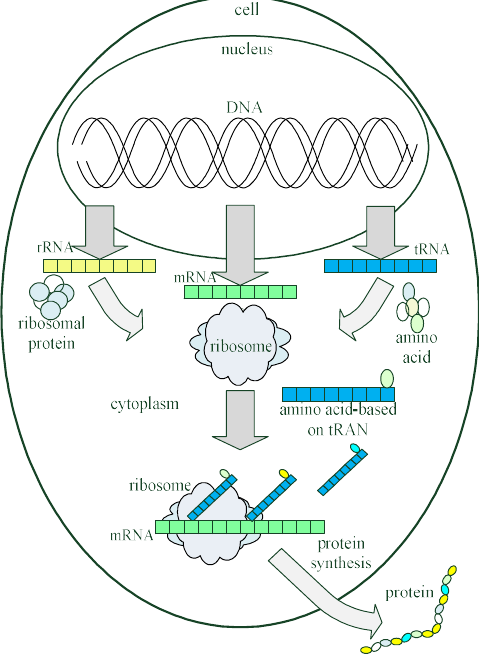
Figure 3. Schematic diagram of protein synthesis.